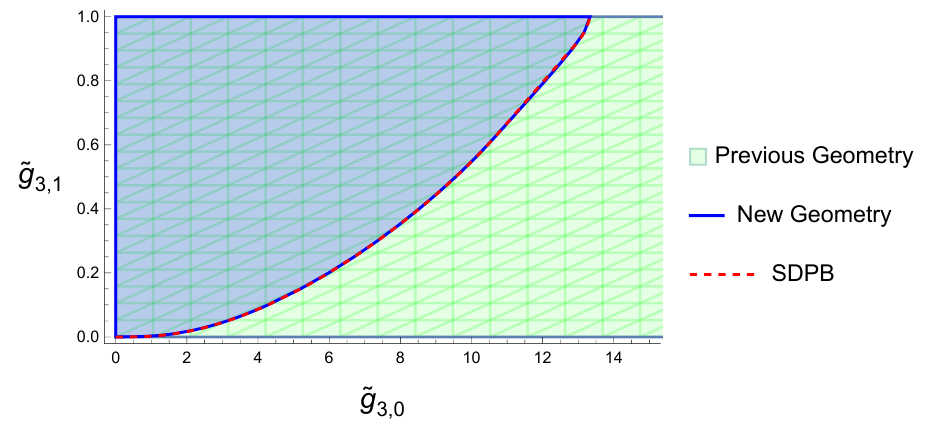
Figure 6 . Comparison of geometry constraints in [14] and new geometry constraints up to k = 5 , and SDPB for (˜ g ˜ g ) . All plots are using k = 5 null constraint due to cyclic 3 , 1 , 3 , 0